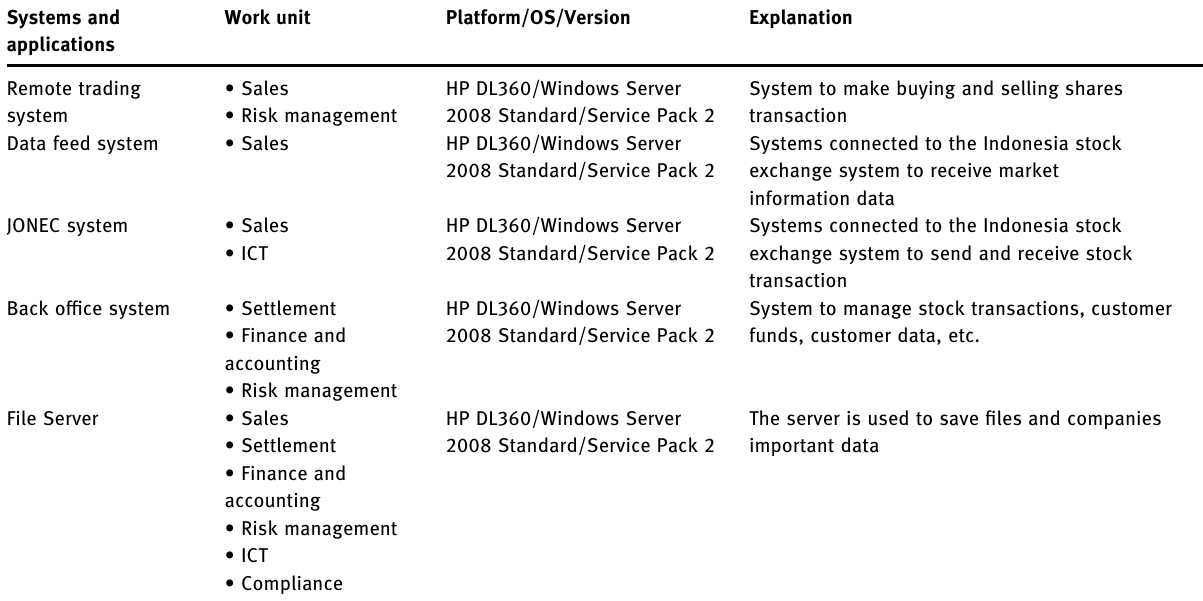
Table 5: Critical resource Systems